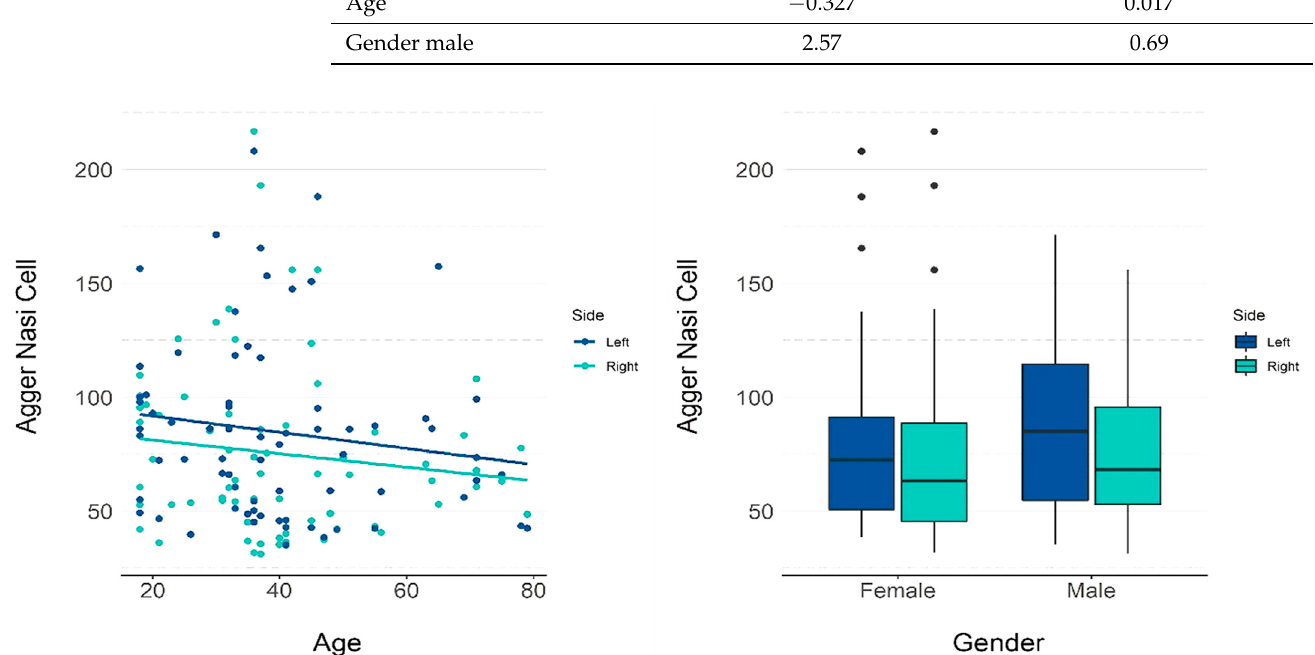
Figure 3. GEE model and scatter plots showing the influence of age and gender on the volume of the agger nasi cell.